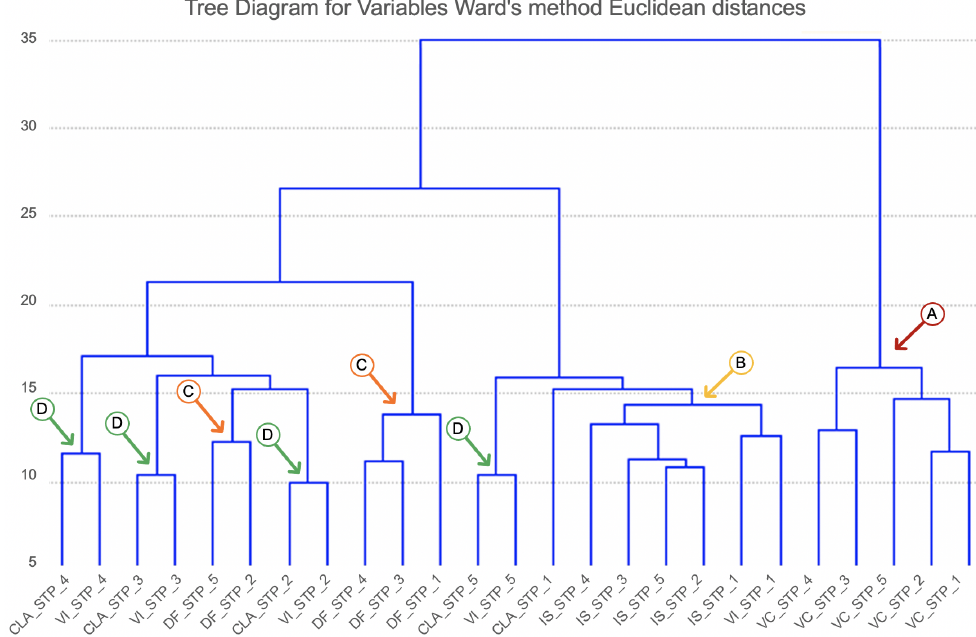
Figure 11. Dendrogram of the visual characteristics for five dimensions: Visual Complexity for selected step (VC_STP_x); Visual Impact for selected step (VI_STP_x); Clarity for selected step (CLA_STP_x); Directed Focus for selected step (DF_STP_x); Inference Support for selected step